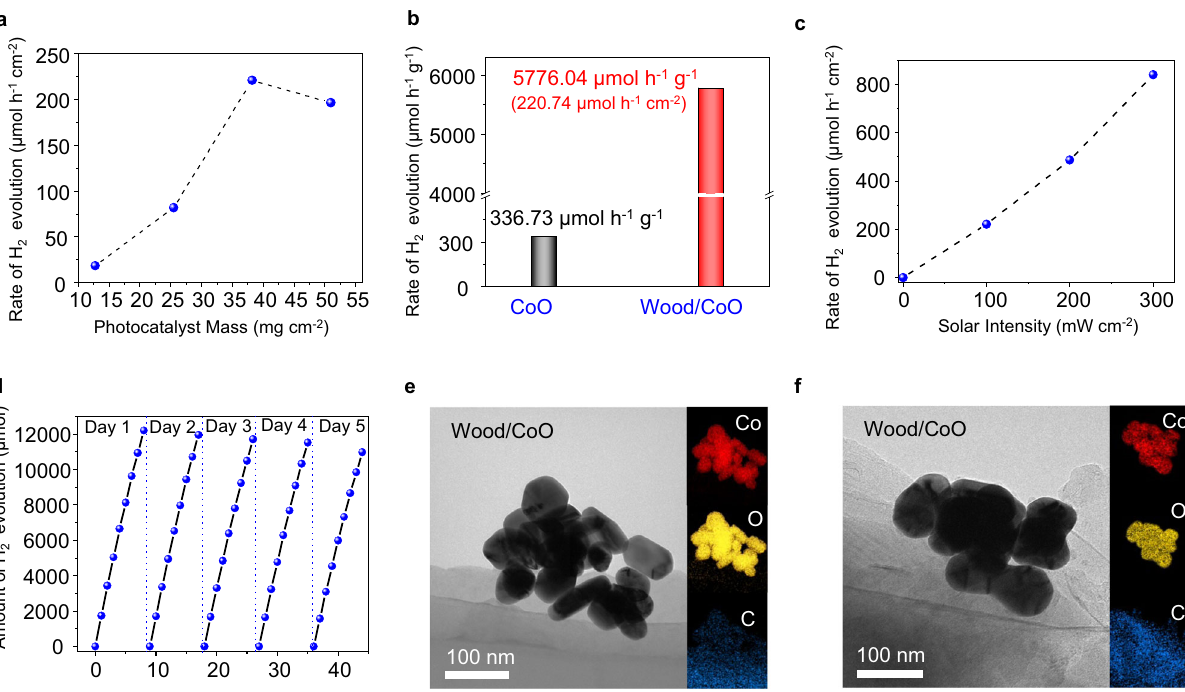
Fig. 2 Photocatalytic hydrogen evolution in the designed wood/photocatalyst biphase photothermal – photocatalytic system. a Mass loading-dependent photocatalytic hydrogen gas production rates for the wood/CoO system (area: 7.85 cm 2 ). b Rate comparison of H 2 evolution in the triphase CoO NPs system and wood/CoO biphase photothermal – photocatalytic system (area: 7.85 cm 2 , mass: 0.3 g). c Rate of H 2 evolution versus solar intensity from the wood/CoO system (area: 7.85 cm 2 , mass: 0.3 g). d Time-dependent photocatalytic hydrogen gas production of the wood/CoO system for 5 days. The light source is a solar simulator at AM 1.5 G illumination (100 mW cm − 2 ). e TEM images and EDS element mapping of CoO NPs attached to the walls of the wood microchannels before the photocatalytic reaction. f TEM images and EDS element mapping of CoO NPs attached to the walls of the wood microchannels after the photocatalytic